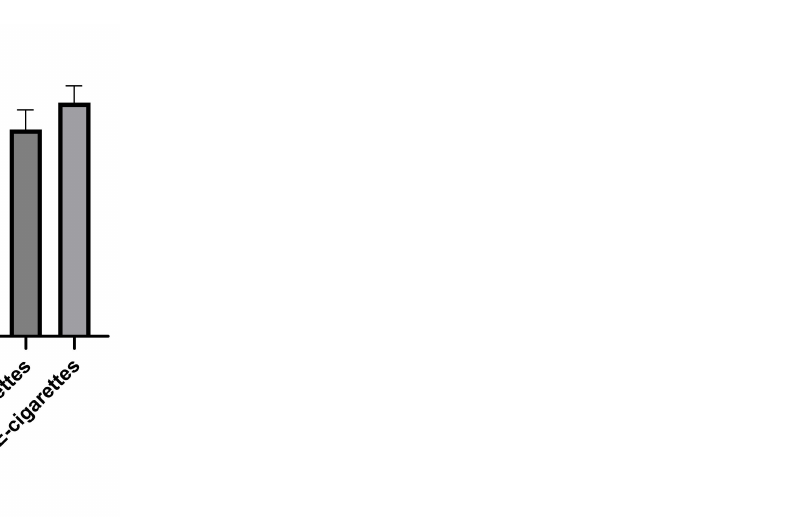
Figure 4. Combined concentrations of uric acid and xanthine in groups of e-cigarettes users, tradi- tional cigarettes smokers and non-smokers.